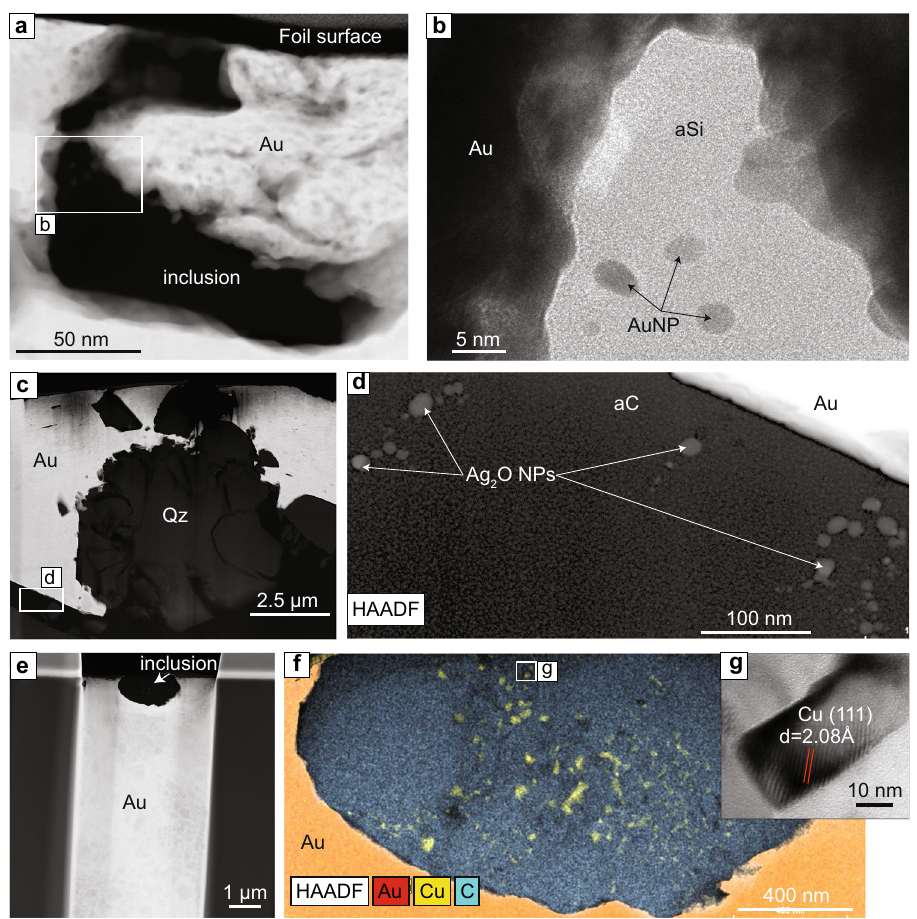
Fig. 4 Gold, silver oxide and copper nanoparticles in amorphous carbon and silica. a High-Annular Dark Field Scanning Transmission Electron Microscopy (HAADF-STEM) image of the inclusion in Discovery sample foil 1. b TEM image of the area indicated by a white rectangle in Fig. 4a that shows the amorphous silica (aSi) phase fi lling the inclusion and round-shape Au nanoparticles (Au NP). c HAADF-STEM image of Discovery foil 2: the light grey crystalline phase corresponds to coarse gold (Au), the dark grey phase corresponds to quartz (Qz) and the black phase within the foil is an amorphous carbon phase (aC). d HAADF image of the area indicated by a white rectangle in Fig. 4c showing round-shape Ag 2 O NPs within the amorphous carbon phase. e HAADF-STEM image of the Sixteen to One foil that shows the inclusion analysed located at the surface of the foil. f Energy-dispersive X-ray spectroscopy (EDS) elemental map overlaying a HAADF-STEM image of the Sixteen to One inclusion showing a composition of micro-crystalline carbon with interstitial Cu NPs. g HRTEM image of the area indicated by a rectangle in Fig. 4f that shows a 50 nm Cu